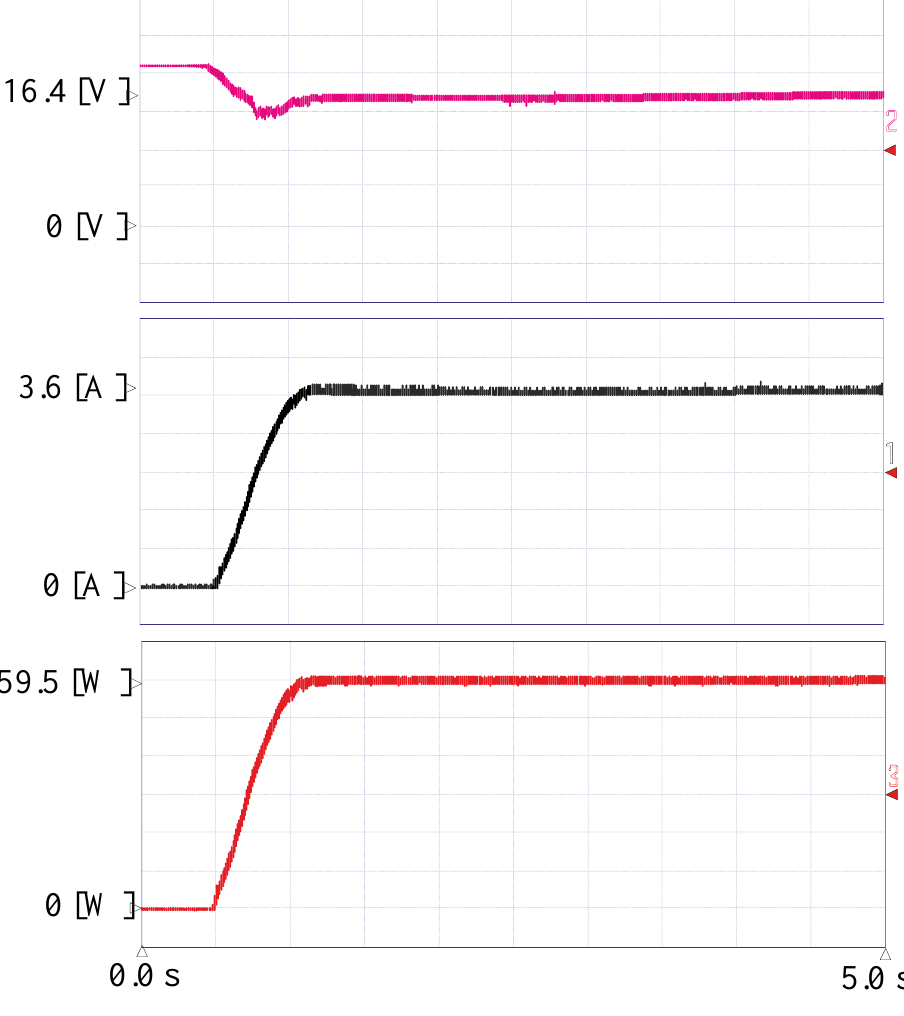
Figure 16. Experimental results of P&O MPPT for case 1.